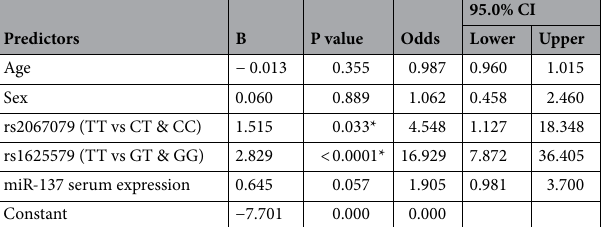
Table 7. Logistic regression analysis. GAS-5 lncRNA growth arrest-specific 5, miR-137 microRNA 137, CI confidence interval. *Significant.